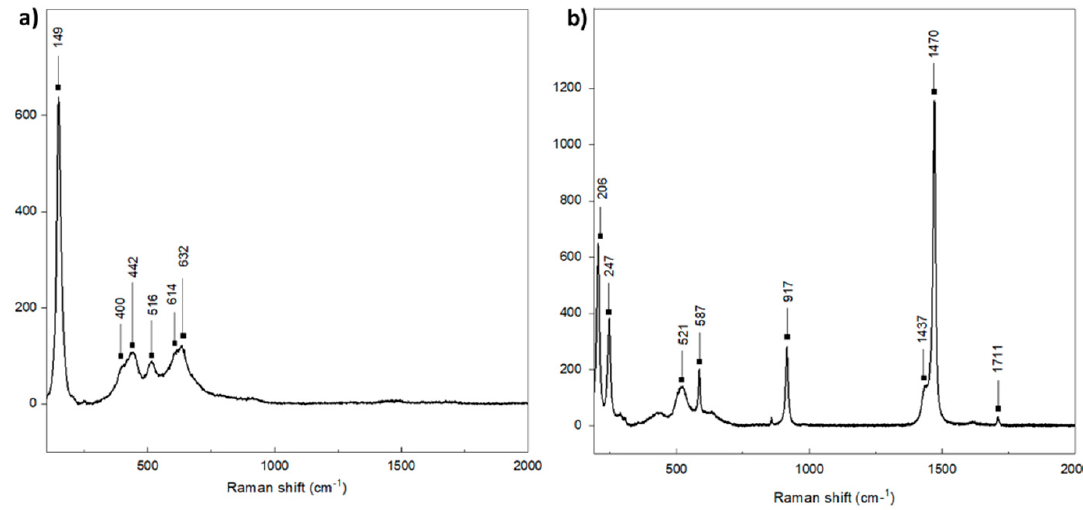
Figure 6. Raman spectra of the ( a ) 1.0 M-WA and ( b ) 1.0 M-WB samples obtained using 1.0 M oxalic acid solution at 155 °C and 50 bar.